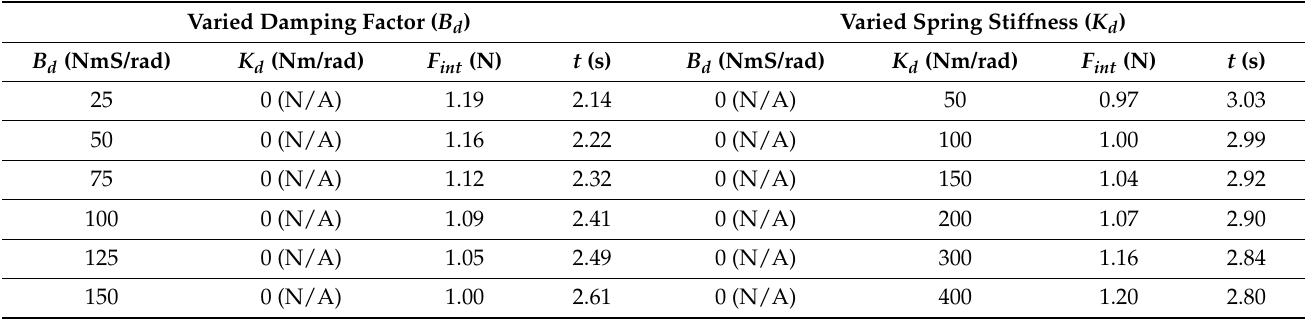
Table 1. Comparisons of the average interactive force ( 𝐹 𝑖𝑛𝑡 ) and time ( 𝑡) parameters, while individually varying the damping factor ( 𝐵 𝑑 ) and spring stiffness ( 𝐾 𝑑 ), respectively.